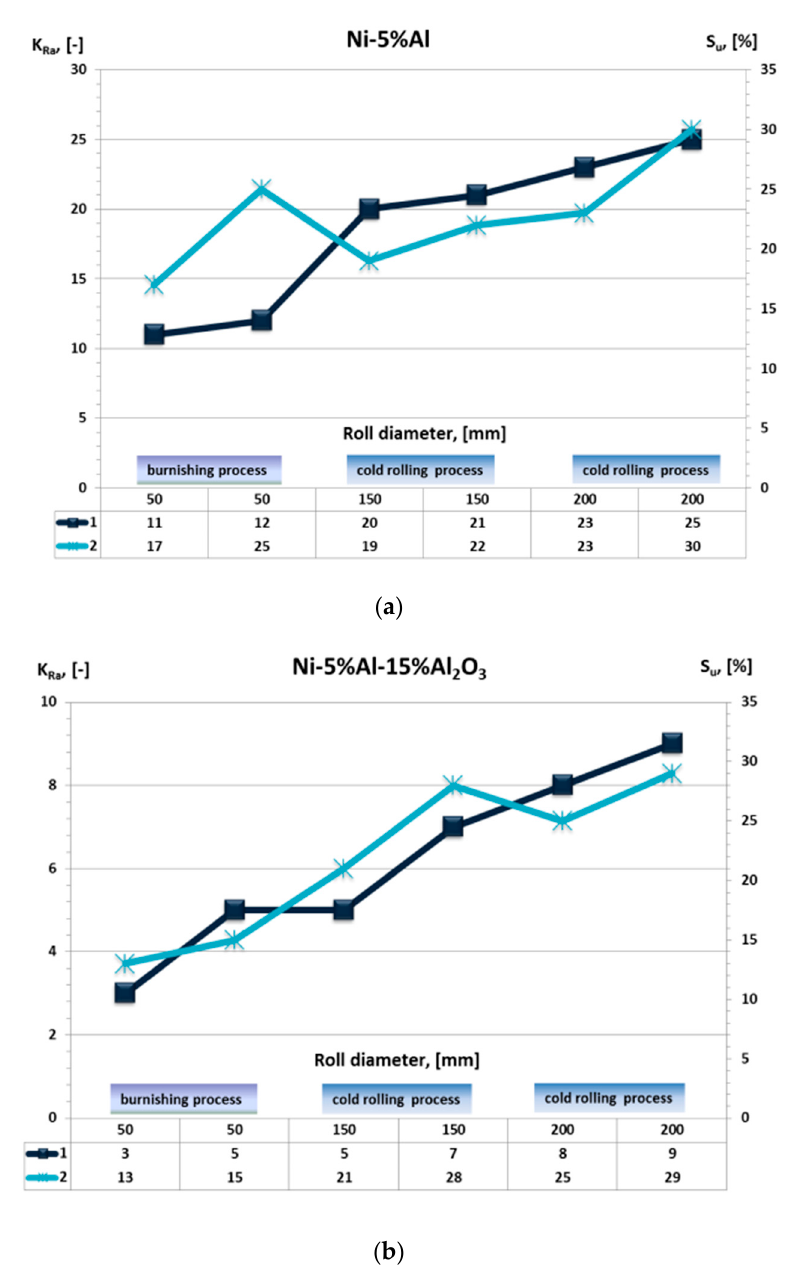
Figure 14. Dependence of the reduction in roughness and increase in strengthening for the ( a ) Ni–5%Al alloy coatings and ( b ) Ni–5%Al–15%Al 2 O 3 composite coatings, with the diameter of the roller at φ 50 mm, burnishing; φ 150 mm, cold rolling; φ 200 mm, cold rolling; where (1) indicator decrease surface roughness (K Ra ) and (2) strengthening (S u ).